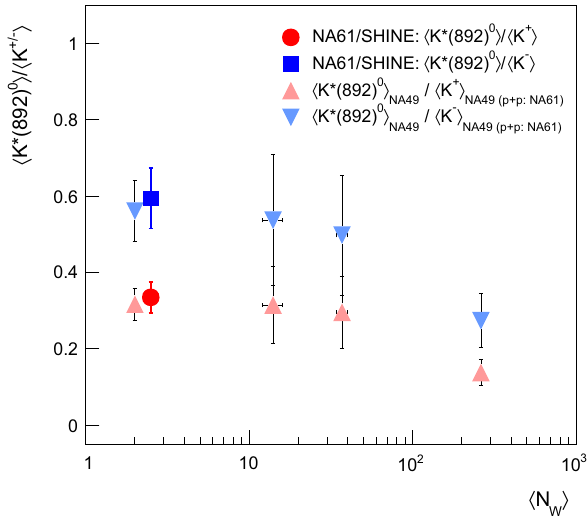
Fig. 16 The system size dependences of (cid:5) K ∗ ( 892 ) 0 (cid:6) / (cid:5) K + (cid:6) and (cid:5) K ∗ ( 892 ) 0 (cid:6) / (cid:5) K − (cid:6) yield ratios in p+p, C+C, Si+Si and Pb+Pb colli- sions at 158 A GeV / c . N W denotes the number of wounded nucleons taken from Ref. [4]. The numerical values are listed in Table 8. For better visibility the NA61/SHINE points are shifted on the horizontal axis – τ is the mean K ∗ ( 892 ) 0 lifetime of approximately